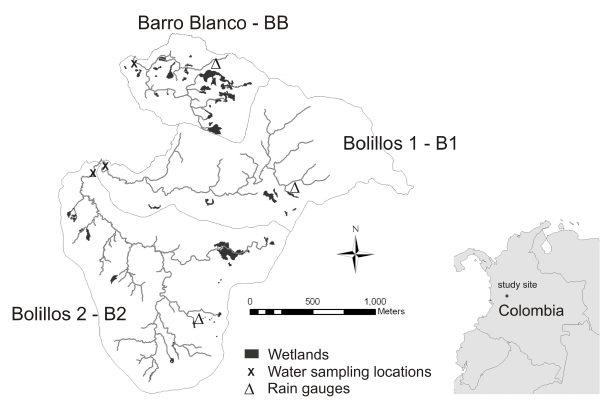
Fig. 1. Location of study site and the three small headwater catch- ments compared. The detailed map shows he wetlands found in each of the three